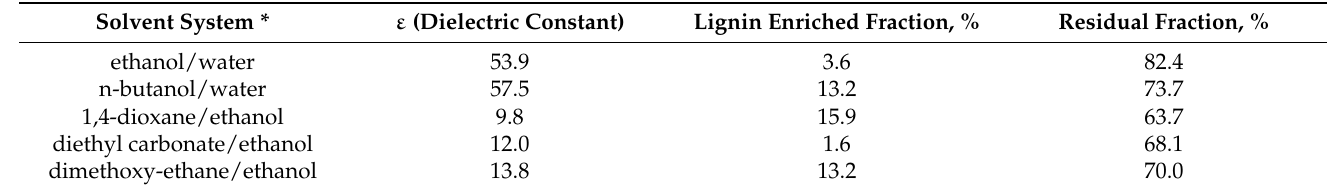
Figure 5. Desirability plot of produced model in terms of time and temperature of delignification reaction . The obtained model shows that a more favorable outcome of delignification reaction can be obtained when utilizing conditions with longer treatment time and higher temper- ature. At the boiling point of butanol (117 °C) and treatment time of 20 h, model